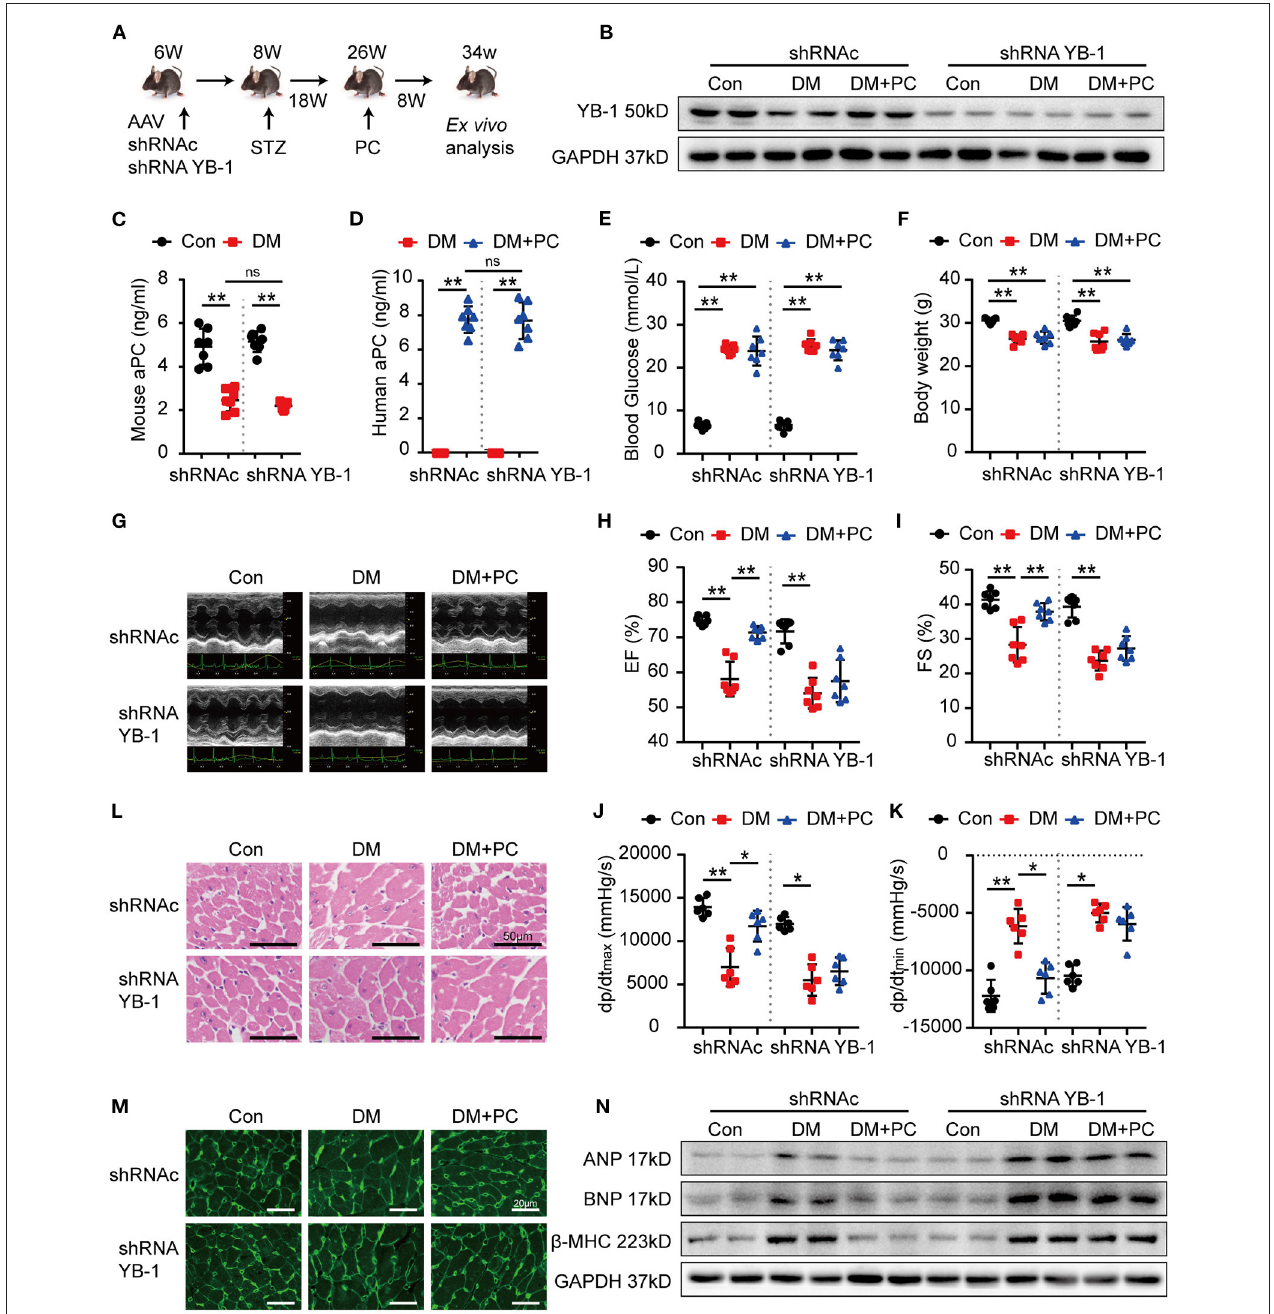
FIGURE 2 | Protection of PC in DCM depends on YB-1. (A) Schematic diagram of animal experiment. C57/BL6J mice were first administrated with YB-1 shRNA AAV9 or scrambled shRNA AAV9 via tail vein at the age of 6 weeks, following with STZ injection and PC intervention at indicated time points. (B) Representative YB-1 immunoblots of mice heart tissue lysates verifying the knock down effect of YB-1 shRNA. (C) Plasma endogenous mouse aPC level and (D) exogenous human PC activation in indicated experimental groups were detected by commercially available ELISA kits. (E) Random blood glucose was detected among the experimental groups. (F) Body weight was measured at the age of 34 weeks. (G) Echocardiographic images of left ventricle and (H,I) scatter plots summarized ejection fraction and fraction shorting results. (J,K) Scatter plots summarized the hemodynamic parameters, which were measured by Millar cardiac catheter system. (L) Exemplary images of H&E-stained heart section. Scale bar: 50 µ m. (M) Exemplary images of WGA-stained heart section. Scale bar: 20 µ m. (N) Western blots showed the expression levels of ANP, BNP, β -MHC in heart tissue from different animal groups. Data were presented as mean ± SD, (C–F,H,I) n = 7 for all groups; (J,K) n = 6 for all groups. Con, control; DM, diabetes mellitus; DM + PC, diabetes mellitus with PC treatment; shRNAc, scrambled non-specific shRNA; shRNA YB-1, YB-1 specific shRNA; EF, ejection fraction; FS, fraction shorting. * P < 0.05, ** P < 0.01. Student’s t -test or two-way ANOVA, Bonferroni comparison test. ns, no significance.